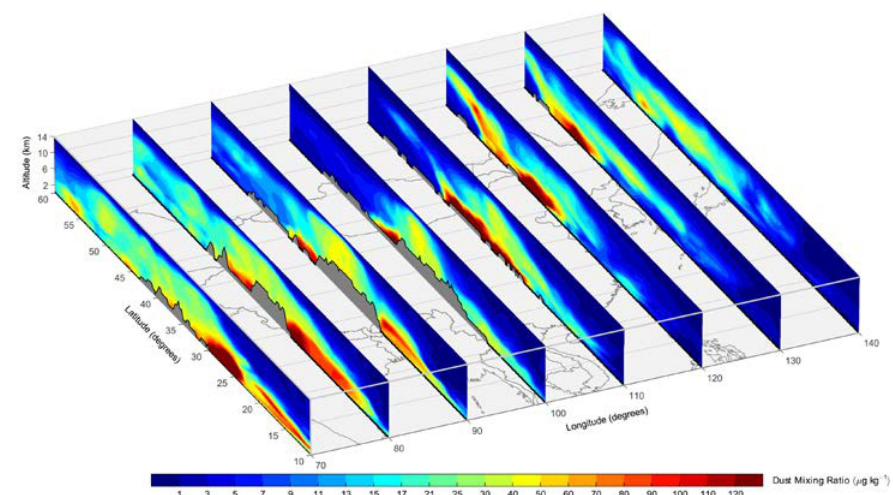
Figure 6. Three-dimensional vertical profiles of the all-bins dust aerosol mixing ratio on 4 May 2017. The vertical distribution of dust at typical a ff ected stations was further analyzed using Lidar